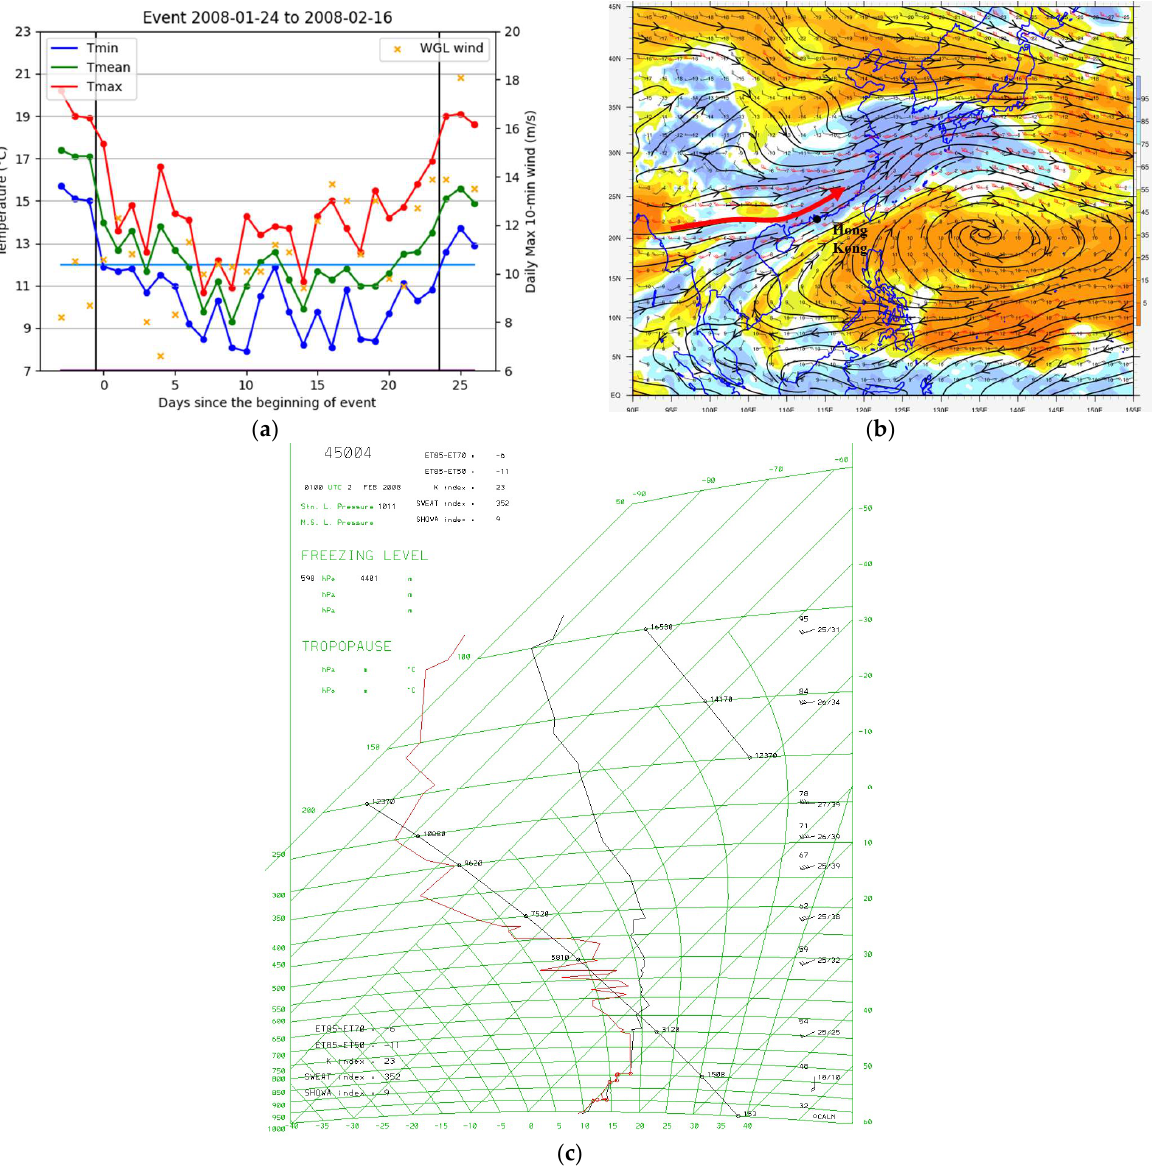
Figure 10. ( a ) Time series of the longest cold event in this study from 24 January to 16 February 2008. The case was not classified as a cold surge. Plotting convention followed Figure 8. For this case, ( 𝑇 , ∆𝑇 , 𝑤 ) = (7.9 °C, −3.3 °C, 12.3 m/s). ( b ) ERA5 reanalysis field for the flow (in streamlines and wind barbs) and relative humidity (colored) at 700 hPa, at 00 UTC on 2 February 2008. The red arrow denotes the southern branch of westerlies. ( c ) Tephigram at King’s Park of Hong Kong at 01 UTC on 2 February 2008.